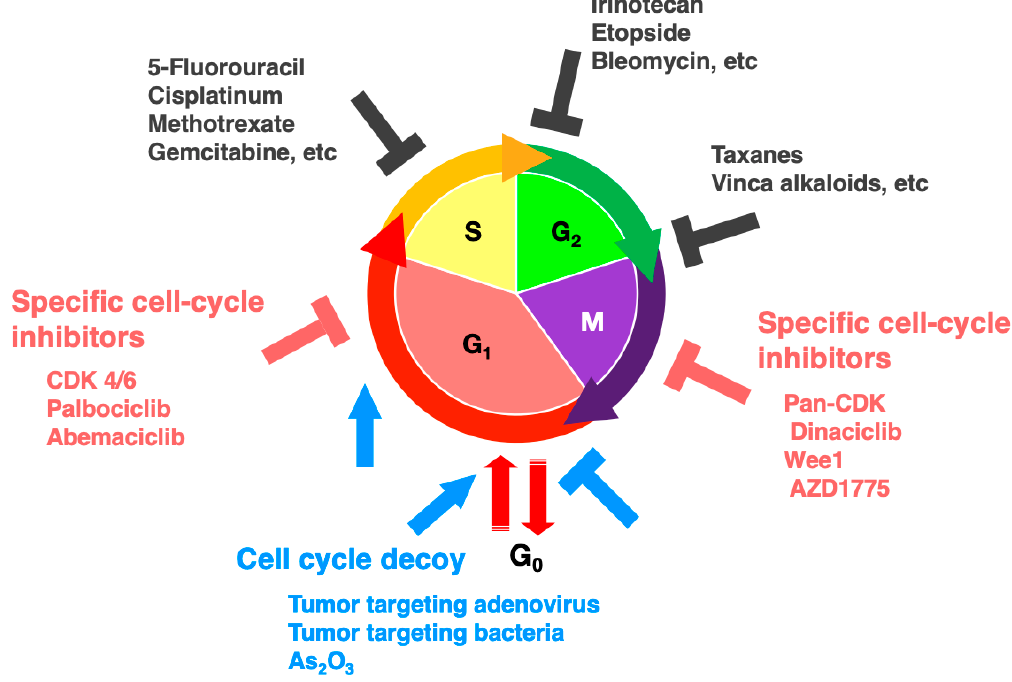
Figure 1. Scheme of cell ‐ cycle phases where therapeutic agents are most effective, which can be imaged with the fluorescence ubiquitination cell ‐ cycle indicator (FUCCI).